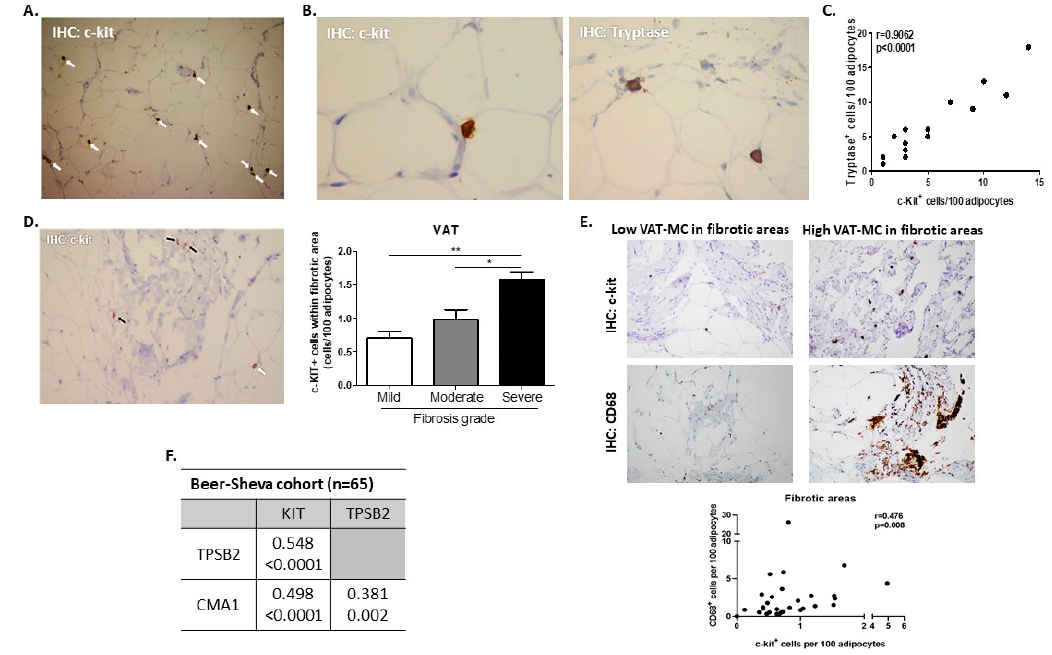
Figure 1. Identification of human visceral (omental) adipose tissue mast cells (AT MC). AT stained for c-KIT Proto-Oncogene Receptor Tyrosine Kinase (C-Kit + , white arrows) with ( A ) × 100 and ( B ) × 400 magnification (left), or stained for tryptase + cells × 400 ( B , right). ( C ) Spearman’s correlation between %C-Kit + and %tryptase + cells (percentage being per 100 adipocytes) in serial AT sections ( n = 14). ( D ) C-Kit + is discernable both within fibrotic areas (black arrows) and around adipocytes (white arrow), and bar graph—the number of C-Kit + cells in sections rated by clinical pathologists (co-authors YD and RSL) as exhibiting mild, moderate, or severe degree of fibrosis. ( E ) Representative histological sections from two representative patients—one with low and the second with high MC in fibrotic areas within VAT, stained for either C-Kit (MC) or CD68 (macrophages). Graph below depicts Spearman’s correlation between %C-Kit + and %CD68 + cells (i.e., macrophages, percentage being per 100 adipocytes) in serial VAT sections within the fibrotic areas, n = 30. ( F ) Spearman’s intercorrelations ( n = 65) between VAT MC-related genes (KIT, TPSB2, and CMA1). In each correlation, the upper line indicates r ( (cid:37) ) value and lower line— p